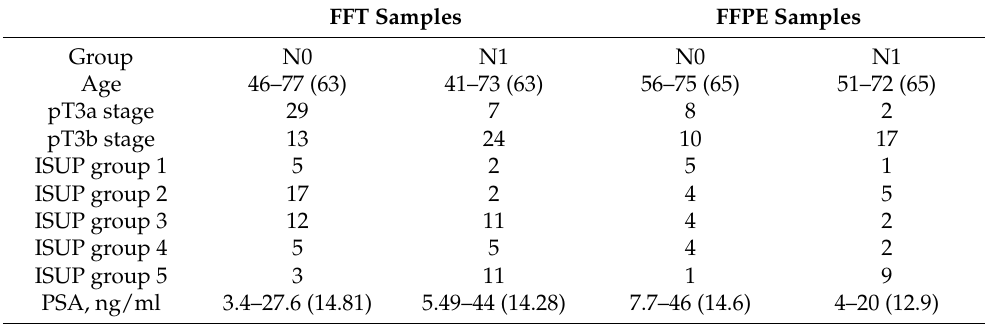
Table 6. Clinicopathological characteristics of LAPC specimens from two cohorts of Russian